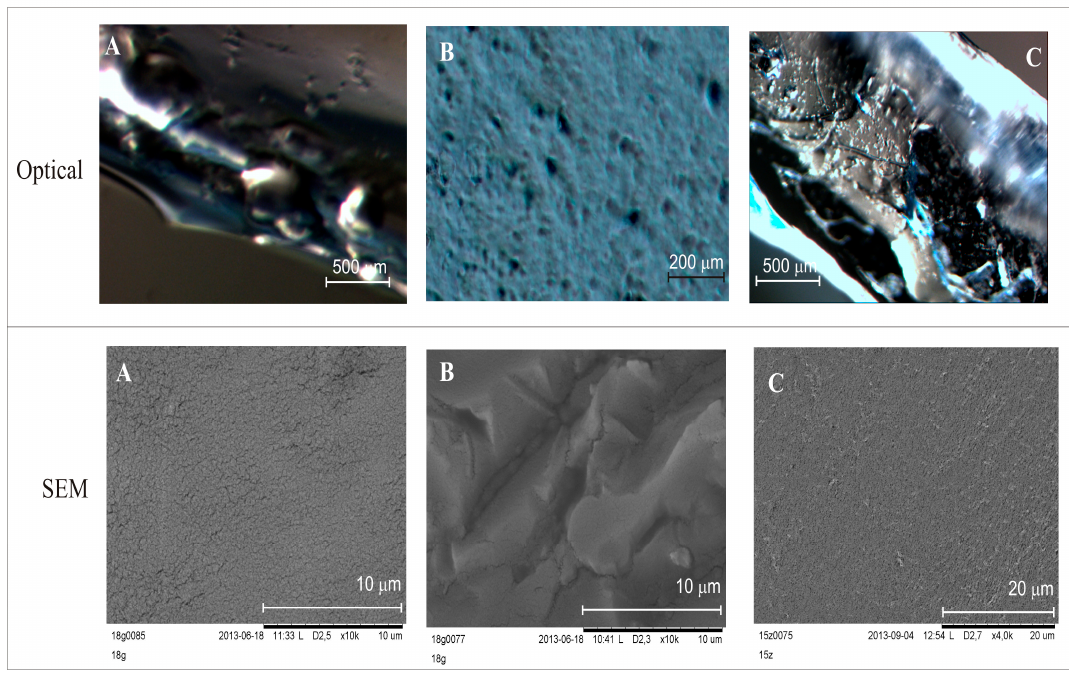
Figure 4. Images obtained by means of optical microscope and SEM: ( A ) adhesive silicone layer of DLASil; ( B ) nonadhesive silicone layer of DLASil; ( C ) Cica-Care patch.